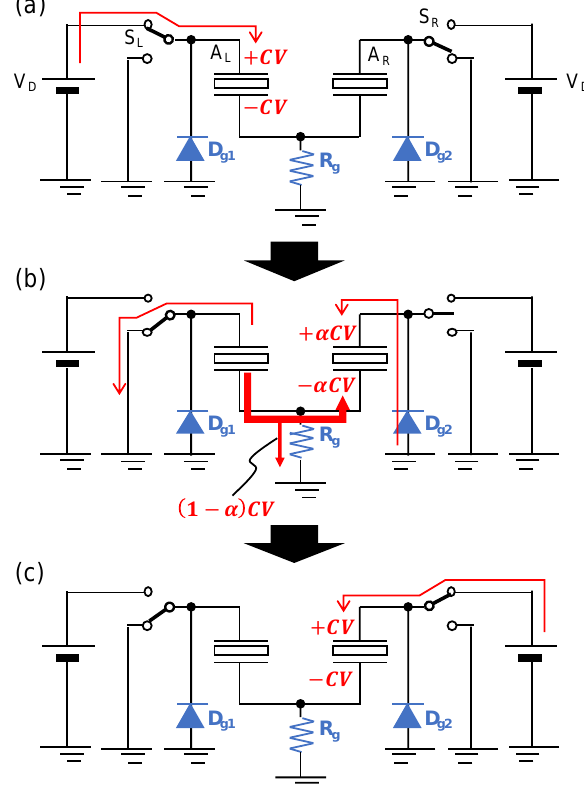
Figure 3. Proposed charge recovery circuit: ( a ) the left actuator is charged by the DC source; ( b ) when the left actuator is switched to ground (GND), a portion of the charge is transferred to the right actuator; ( c ) the right actuator is charged by the DC source.